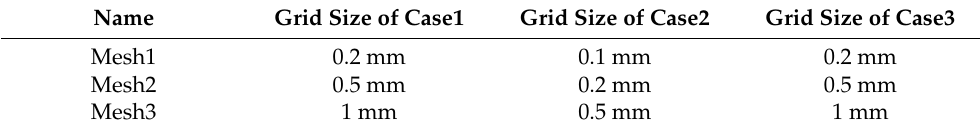
Table 2. Mesh configuration.